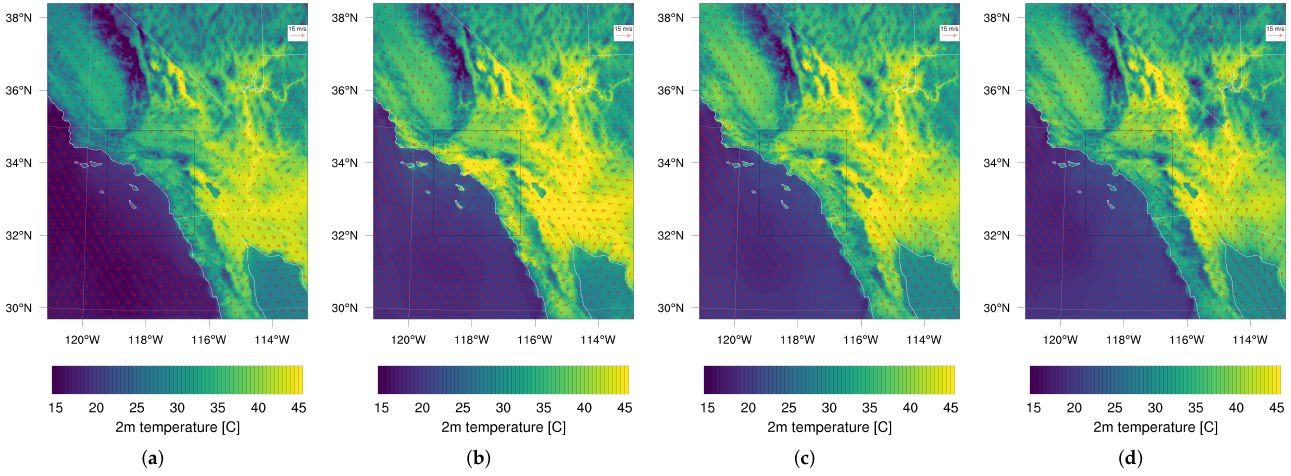
Figure 2. Modeled 10 m wind speed and 2 m temperature on 5 July, 3 p.m. ( a ), 6 July, 3 p.m. ( b ), 7 July, 3 p.m. ( c ), and 8 July, 3 p.m. ( d